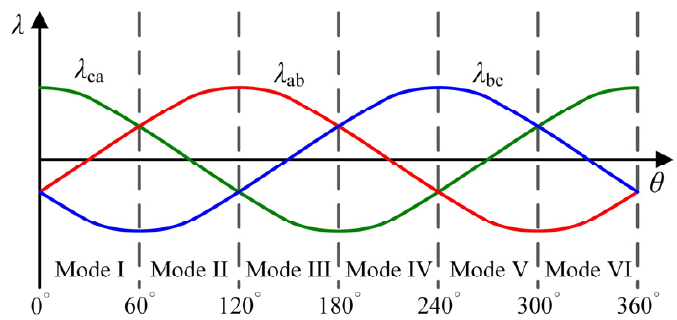
Figure 3. Line-to-line PM flux linkage with rotor position waveform.